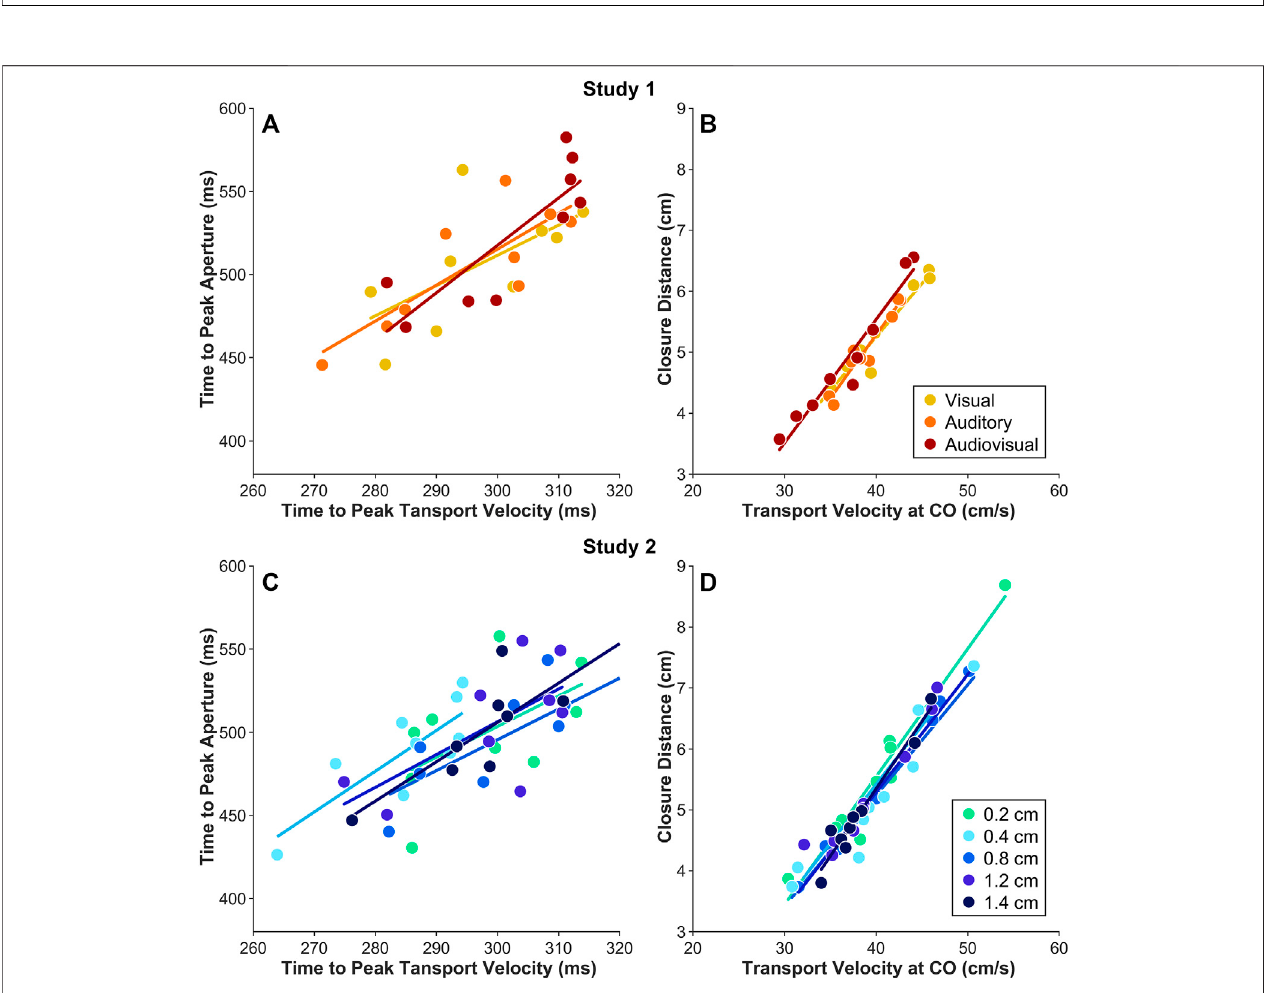
FIGURE 7 | Effects of sensory feedback (Study 1, A & B ) and collider size (Study 2, C & D ) on reach-to-grasp coordination. (A , C) Temporal coordination: time to peak transportvelocityvs.timetopeakaperture. (B , D) Spatialcoordination:transportvelocityatCOvs.closuredistance.Manipulationofsensoryfeedbackandcollider size did not alter reach-to-grasp coordination, indicating that the state-of-the-art hf-VE can support stable reach-to-grasp movement coordination patterns.